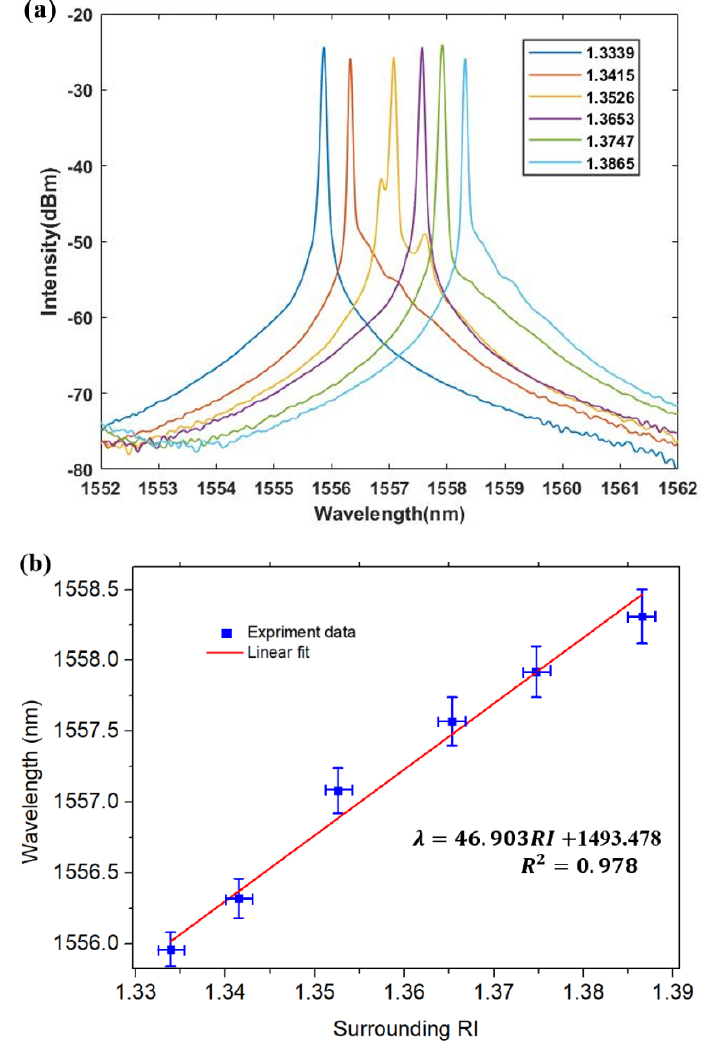
Figure 6. ( a ) Measured output spectra of the RI from 1.3339 to 1.3865 for 75.5 µ m side-polished fiber; ( b ) Measured Linear relationship of the RI from 1.3339 to 1.3865 for 75.5 μ m side-polished fiber. With the increase of temperature t the transmission spectrum of the side polished fiber in the FRL system shifts accordingly. When the temperature is changed from 25 ◦ C to 31 ◦ C, the spectral response to the different temperatures is shown in Figure 7a,b. Note that the transmission spectrum undergoes a blueshift with the increase of temperature. As shown in Figure 7b, the temperature sensitivity is − 1.60 nm/ ◦ C. When the diameter of the fiber is 75.5 µ m, the relationship between the emission wavelength and the temperature can be fitted linearly ( R 2 =